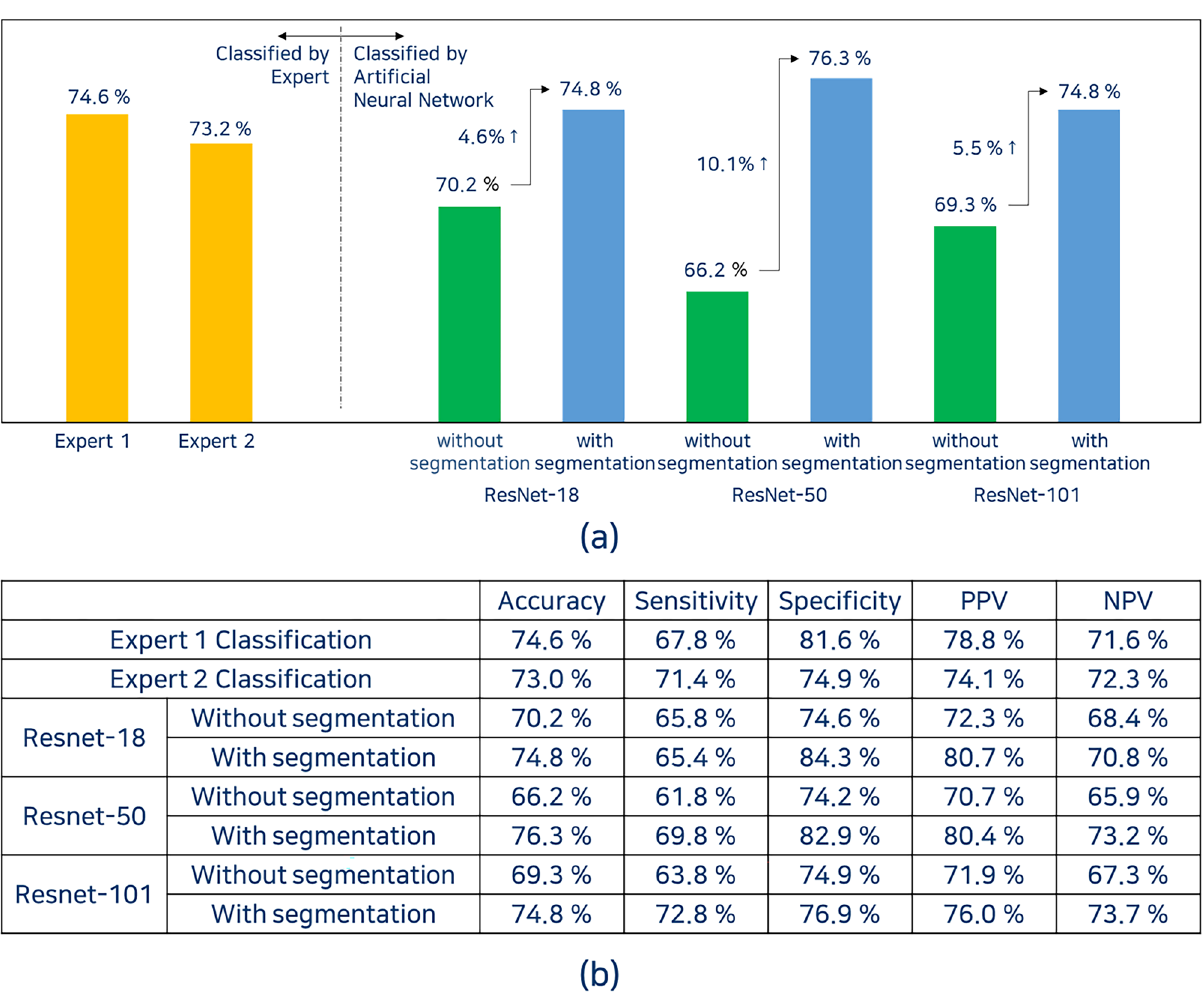
Figure 7. Classification performance ( a ) Classification performance with or without segmentation ( b ) Detailed evaluation results of the classification